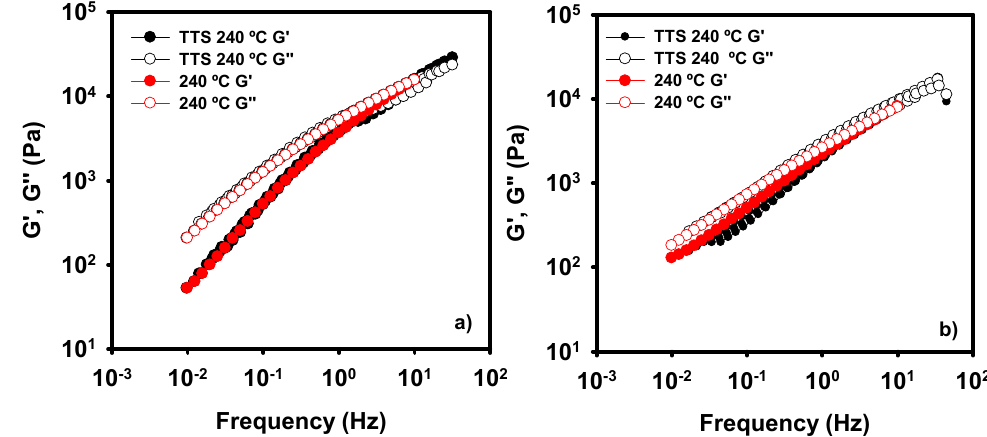
Figure 6. TTS curves for neat PE ( a ) and PE + WA-LDH ( b ) nanocomposite with surfactant.